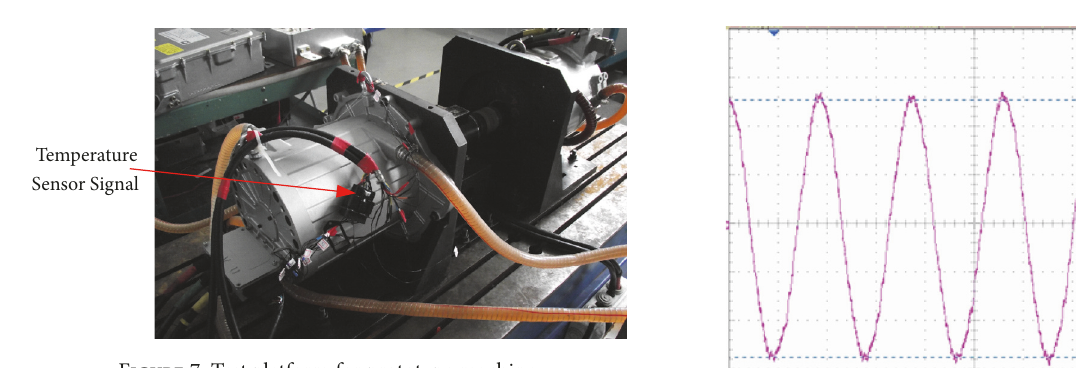
Figure 7: Test platform for prototype machine.